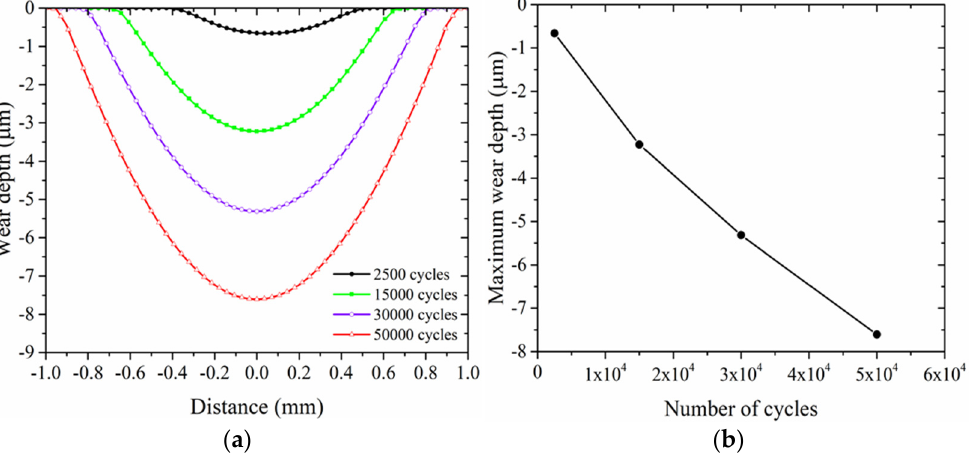
Figure 8. ( a ) Evolution of fretting wear profile on the copper specimen and ( b ) evolution of the maximum fretting wear depth.